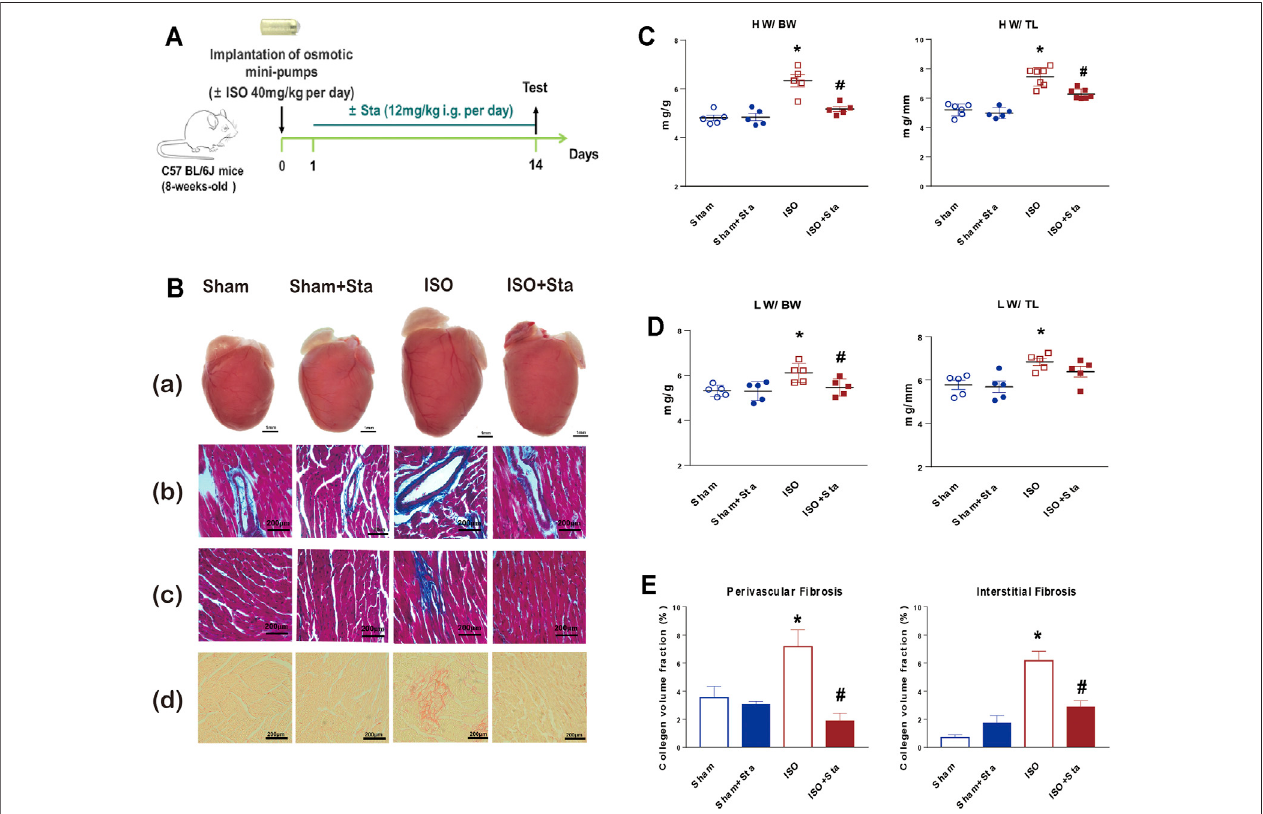
FIGURE1| Stachydrinehydrochloride reduces cardiac remodeling induced byISOinmice. (A) Timeline diagram ofphenylephrineinmice. (B) Cardiac images: (a) comparison of heart size in mice that underwent Sham, Sham + Sta, ISO only, or ISO + Sta treatment; (b, c) collagen deposition was further recorded using Masson stainingon6- μ m-thickheartsections; (d) collagendepositionwasfurtherrecordedusingSiriusredstainingon6- μ m-thickheartsections. (C) HW:BWandHW:TL( n =5 in each group). (D) LW:BW and LW:TL ( n = 5 in each group). (E) Quanti fi cation of cardiac perivascular and interstitial fi brosis ( n = 5 in each group). The data are expressed as mean ± standard error of mean, * p < 0.05 vs. Sham; # p < 0.05 vs. ISO. ISO, isoproterenol; Sta, stachydrine hydrochloride; HW, heart weight; BW, body weight; LW, lung weight; TL, tibial